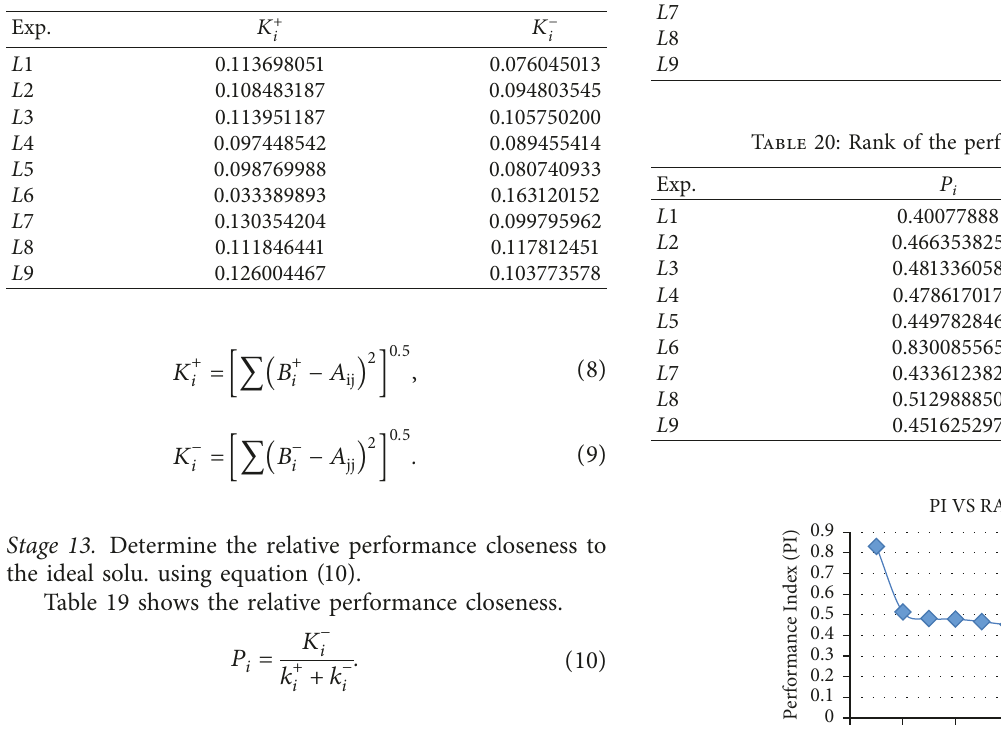
B − i ) and ideal ( i ).